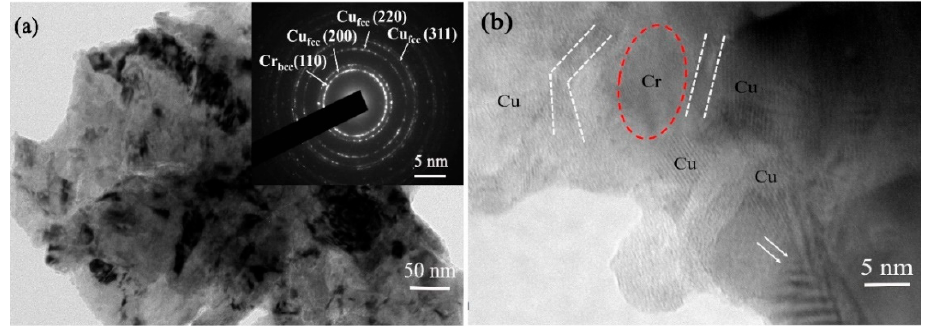
Figure 8. The microstructure of Cu-Cr alloying powders subjected to MA for 12 h: ( a ) bright-field image (the inset bottom-right is SAED pattern); ( b ) typical HRTEM image.